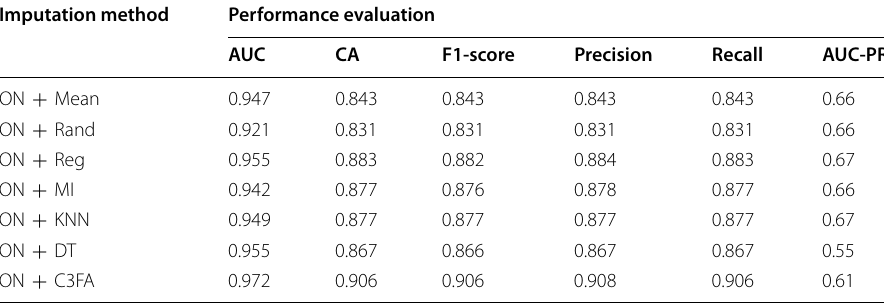
Table 6 Comparison result of RMSE, DKS, and r (ON